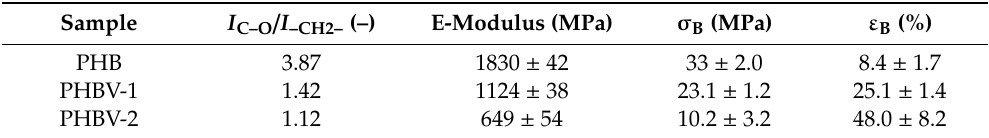
Table 3. Crystallinity index and mechanical behavior of the PHB, PHBV-1, and PHBV-2 sca ff olds. (average value ± SD, n = 5). I C–O / I –CH2– : the ratio of the intensity at 1225 cm − 1 to the intensity at 1453 cm − 1